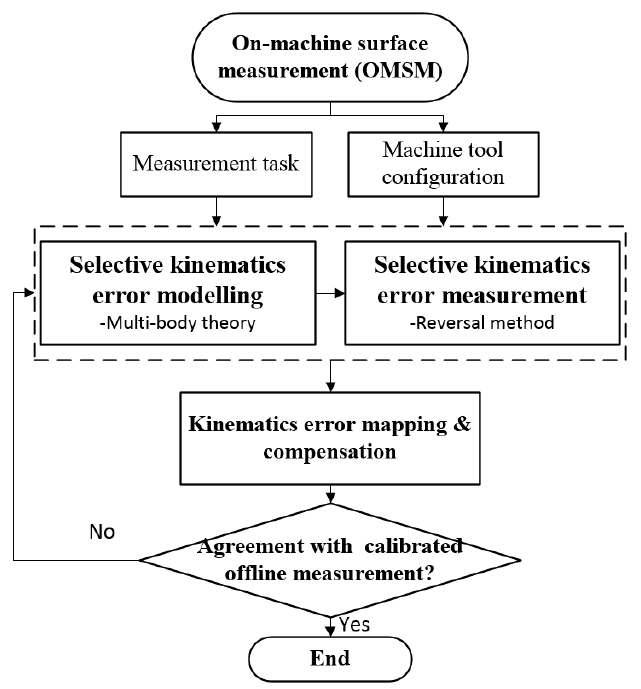
Figure 2. Flowchart of the kinematics error compensation for on-machine surface measurement (OMSM).